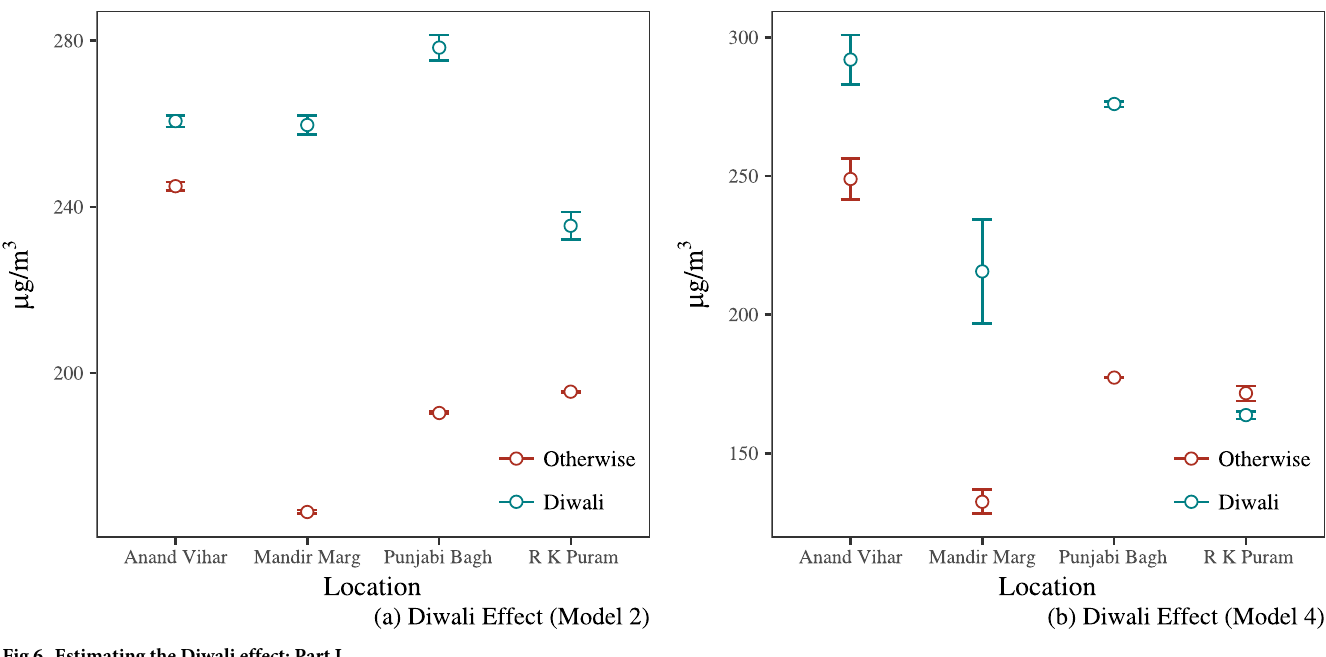
Fig 6. Estimating the Diwali effect: Part I.